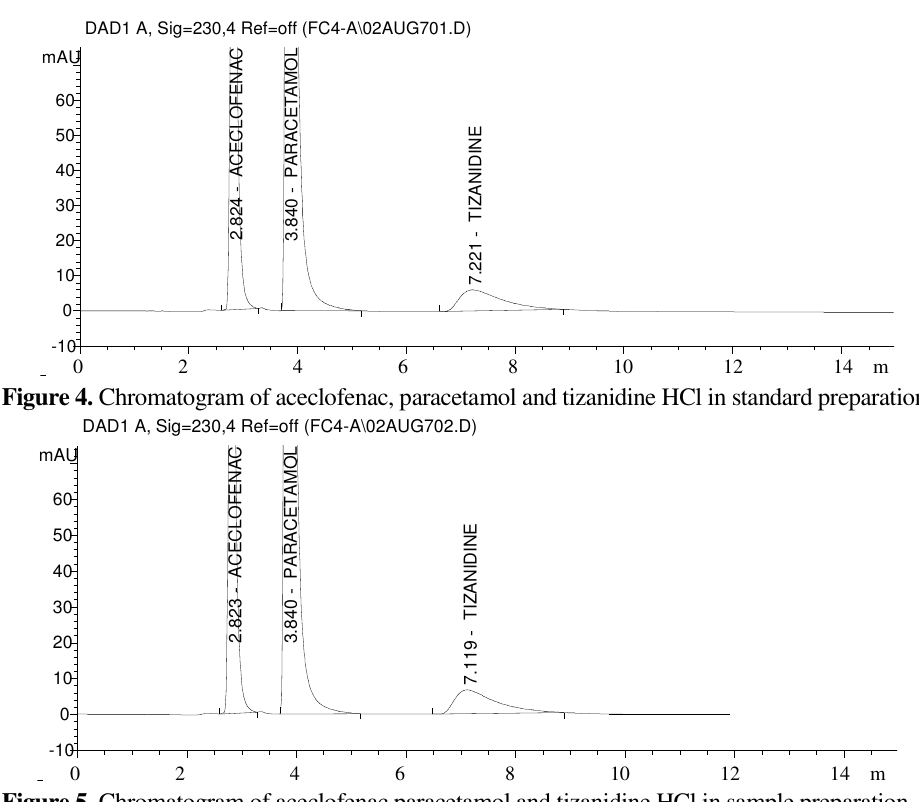
Figure 5. Chromatogram of aceclofenac paracetamol and tizanidine HCl in sample preparation. Working standard